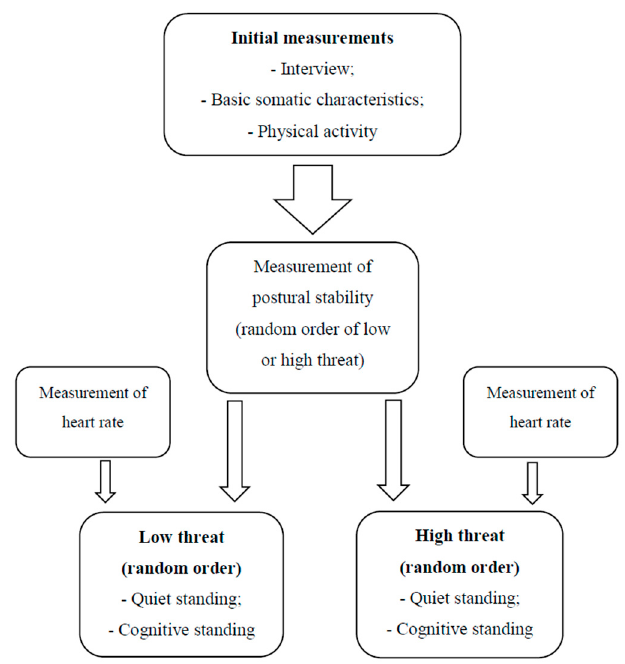
Figure 1. General overview of the experiment.